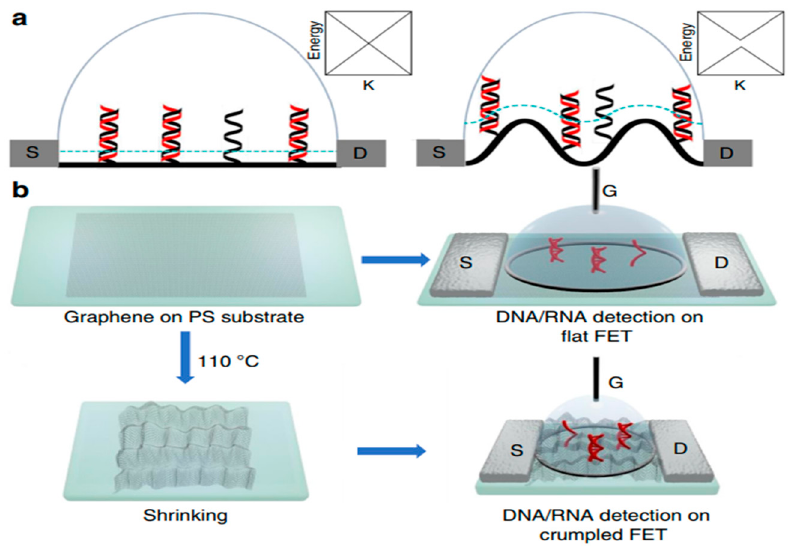
Figure 5. Scheme and characterization of ( a ) flat and ( b ) crumpled graphene FET biosensor. Repro- duced with permission from Ref. [13]. Copyright 2020 Springer Nature. Licensed under a Creative Commons Attribution (CC BY) License.